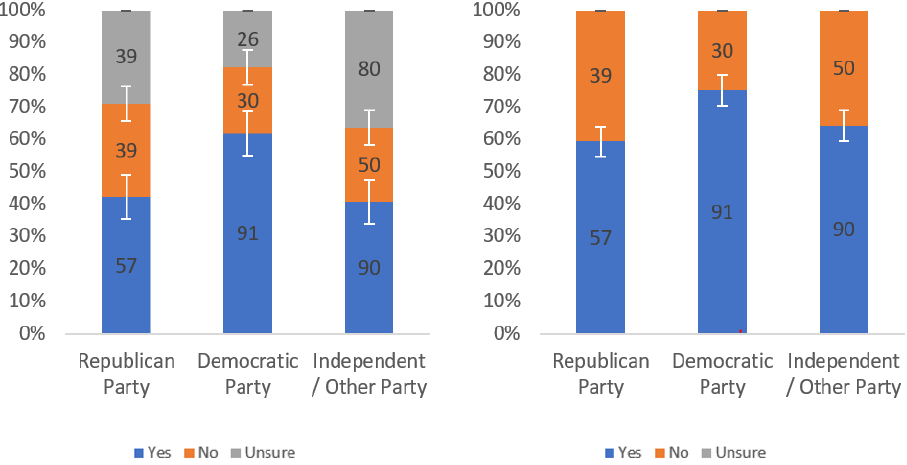
Figure A11. Responses regarding others’ willingness to review by party affiliation including ( left ) and excluding ( right ) unsure responses.